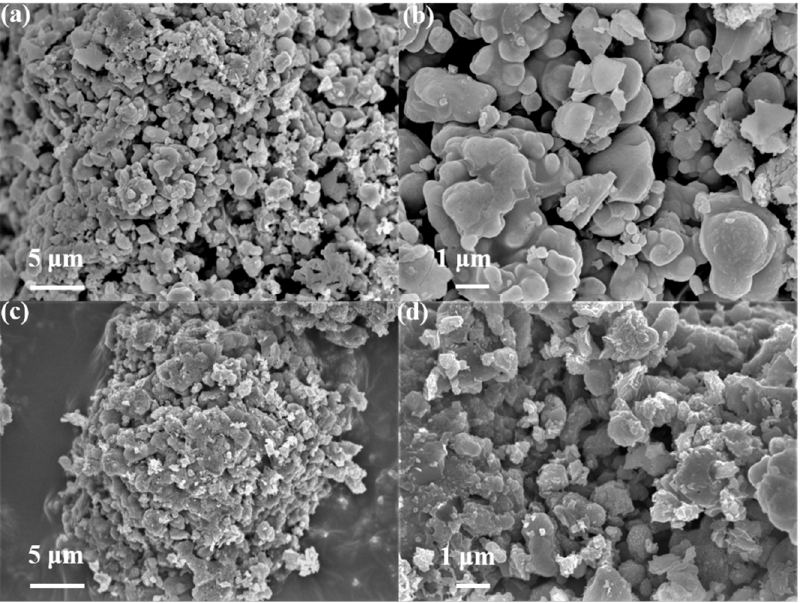
Figure 3. SEM images of ( a , b ) pristine NMCP and ( c , d ) as-synthesized NMCP/rGO under different magnifications.